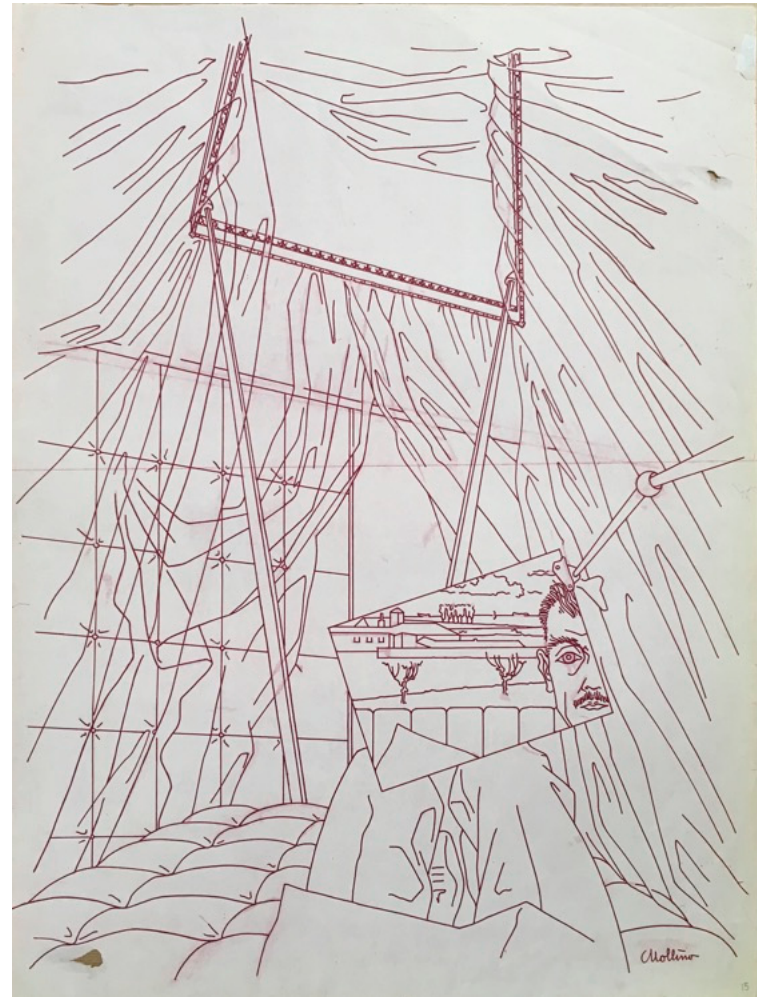
Figure 2. ACM P.9C.92.4: Central perspective from the bed with Carlo Mollino’s face reflected in the